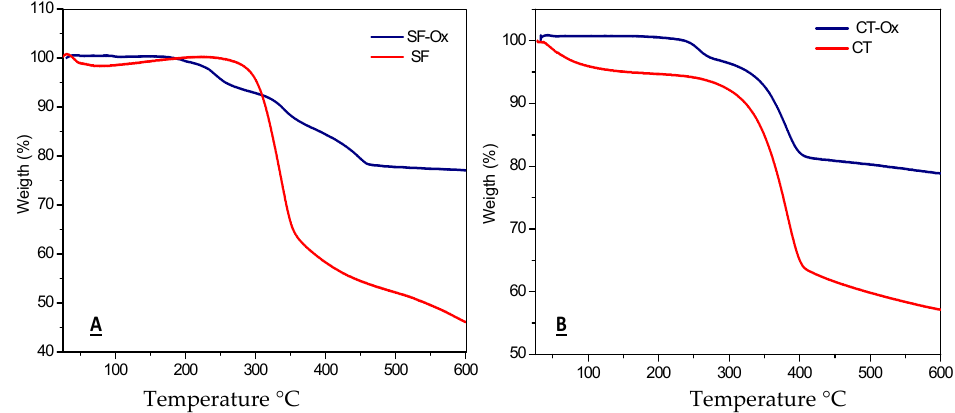
Figure 5. Thermogravimetric analysis of the biopolymers SF-Ox and SF ( A ); CT-Ox and CT-Ox ( B ).